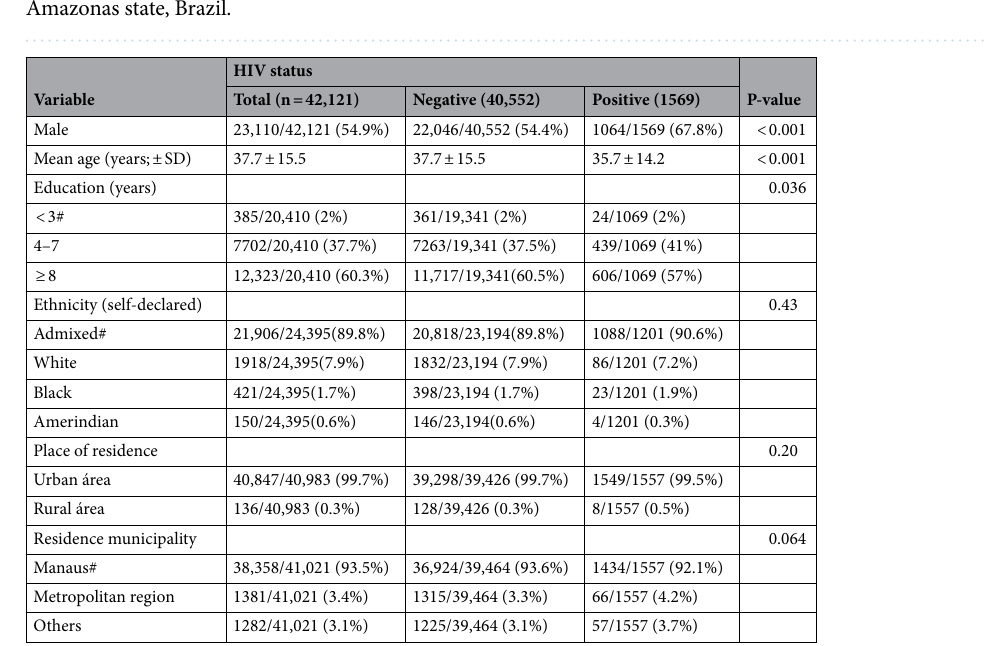
Table 1. Demographic characteristics of the included participants according to HIV status, tested at the FMT- HVD, Brazil, between 2012 and 2016. # Reference